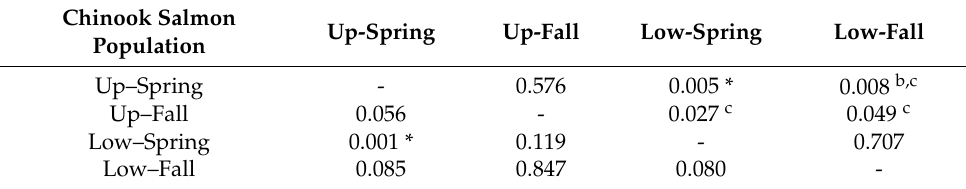
Table 5. p Values for regression coefficients examining the relationship between experimental host population and infection status (below diagonal) and log 10 viral load outcome (above diagonal), assessed using logistic regression and generalized linear models (GLMs), respectively a